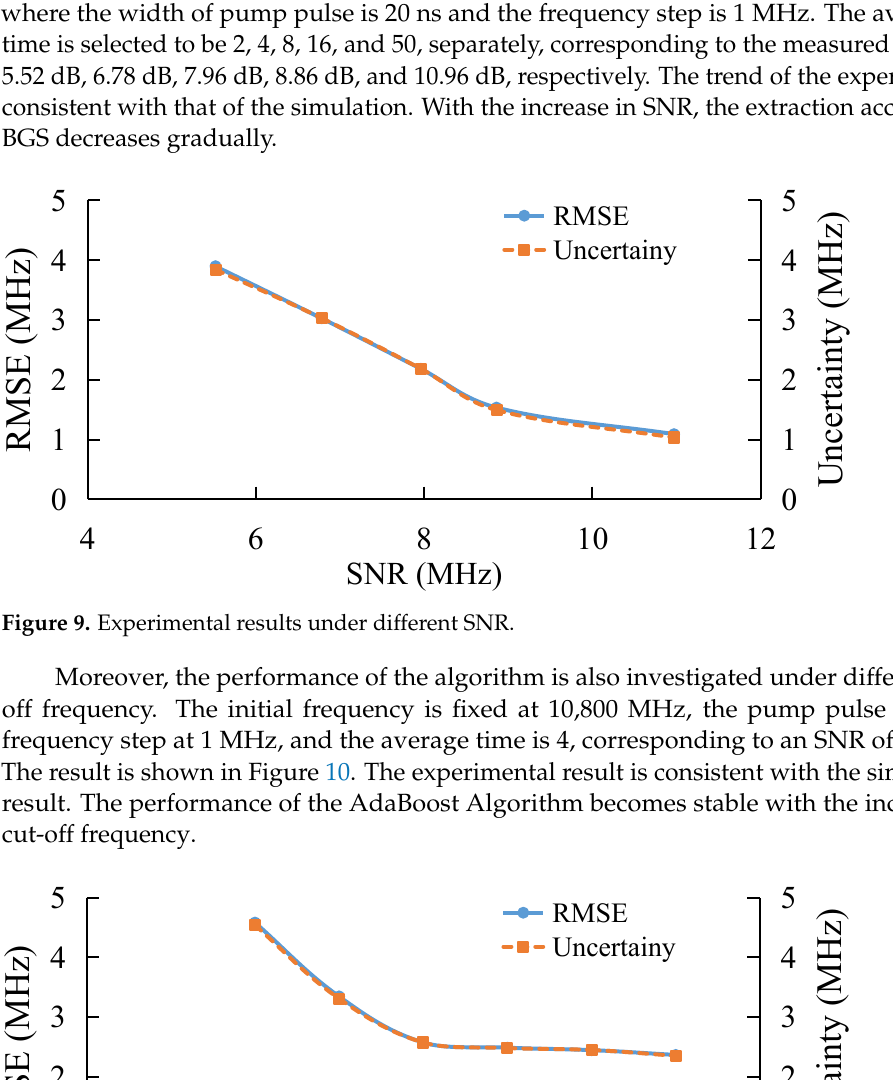
Figure 8. ( a )Measured BGS distribution along 1000 km FUT with last 1000 m section heated at 30 °C, and ( b ) BFS distribution.